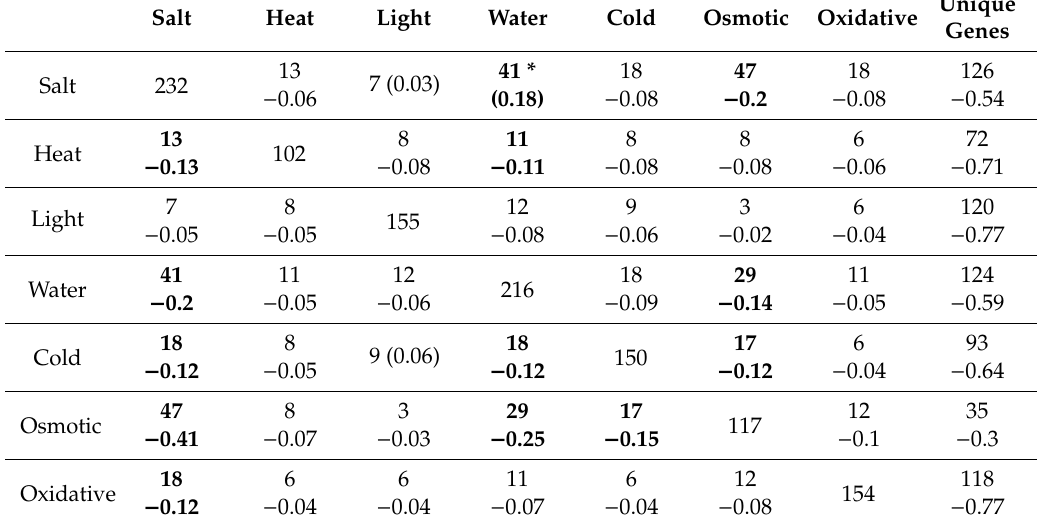
Table 2. The number of common genes between pairs in stress-related gene sets. Each cell in the table represent the fraction (and number, in parentheses) of genes from the set of the row common with the set of the column. The last column represents the number of unique genes for the stress in the